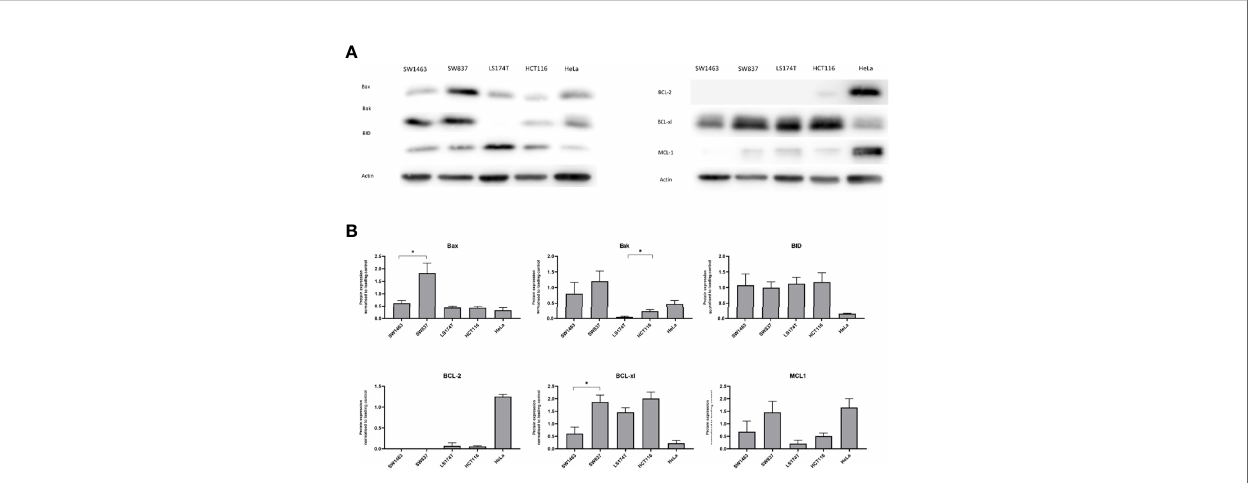
FIGURE 2 | BCL-2 family protein levels in mucinous versus non-mucinous colon and rectal cancer cell lines. (A) Representative blots of BCL-2 family proteins at baseline; (B) BCL-2 family protein expression normalized to loading control. *p<0.05. p value for t test comparing mucinous versus non mucinous cell lines in colon and rectal cancer. N=3 experimental